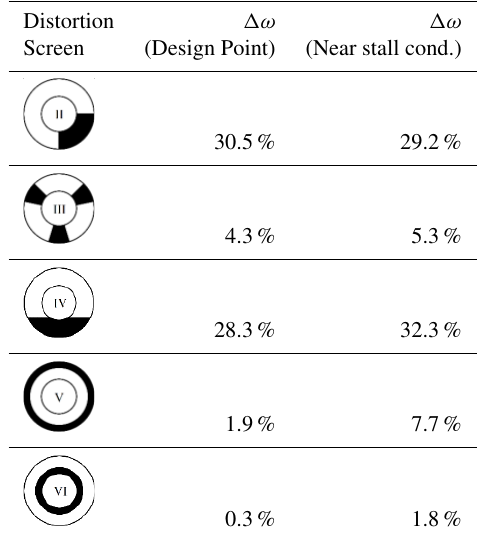
Table 1: Reduction in spanwise averaged total pressure rise coefficient relative to the undistorted case.